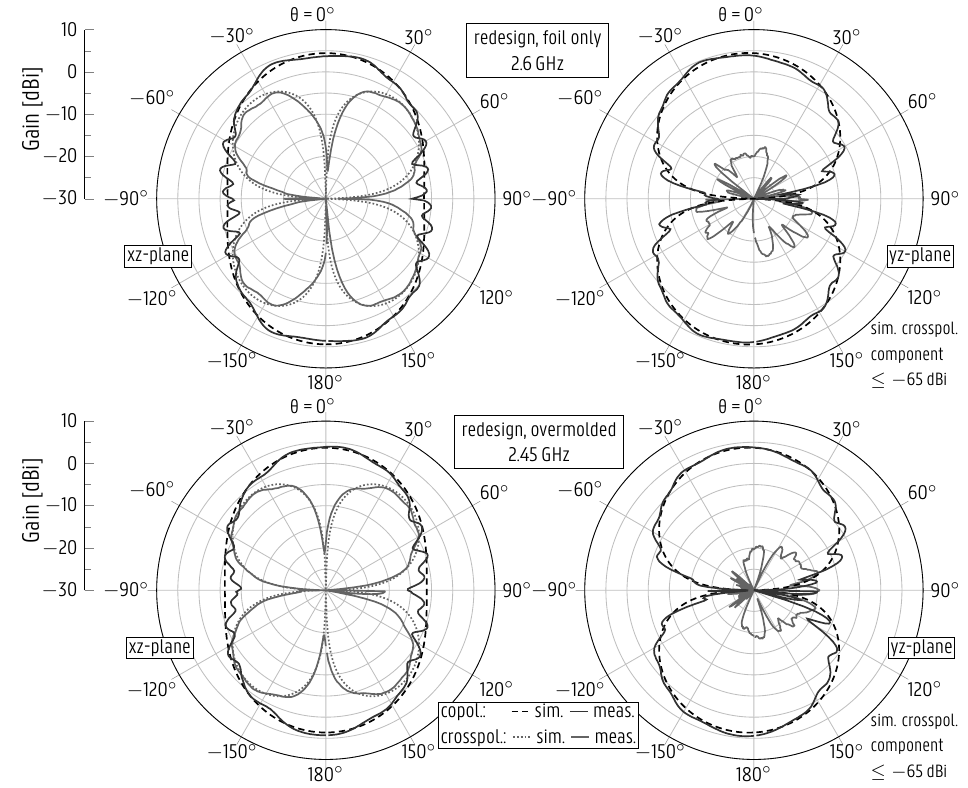
Figure 10. Simulated and measured radiation patterns of the redesigned coplanar patch antenna, stand-alone printed on plastic foil ( top ) and after overmolding ( bottom